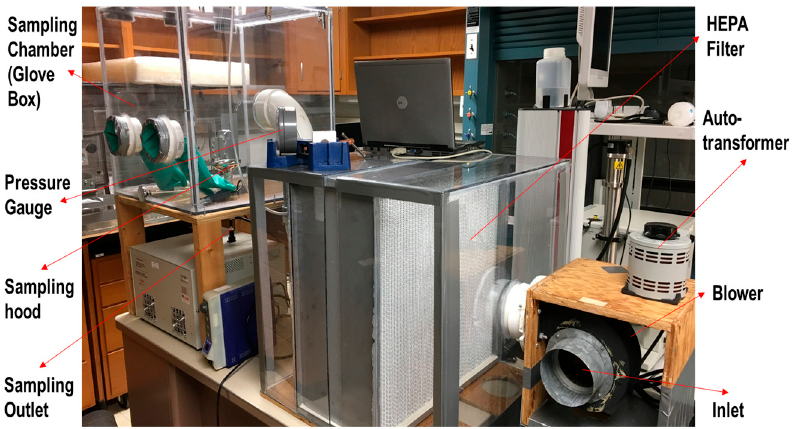
Figure 1. Experimental system employed for collecting and quantifying particles. A blower controlled by an autotransformer blew room air through one high-efficiency particulate air filter (HEPA) into the sampling chamber. A scanning mobility particle sizer (SMPS 3936, TSI Inc., Shoreview, MN, USA), aerodynamic particle sizer (APS 3314, TSI Inc., Shoreview, MN, USA) and nano micro-orifice uniform deposit impactor (0.2 µ m pore size, 47 mm in diameter, Sterlitech Corporation, Kent, WA, USA) were installed outside the system with sealed tubes connecting to the chamber. Mixed cellulose esters (MCE) filters (0.8 µ m pore size, 47 mm diameter, Zefon International, Inc., Ocala, FL, USA) were inserted in the nanoMOUDI for particle collection.